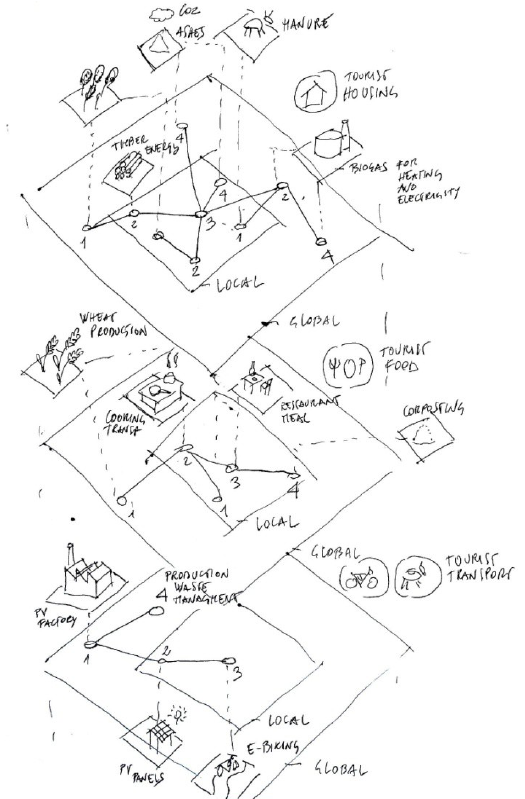
Figure 8. Simplified Impact Geography of the main tourist